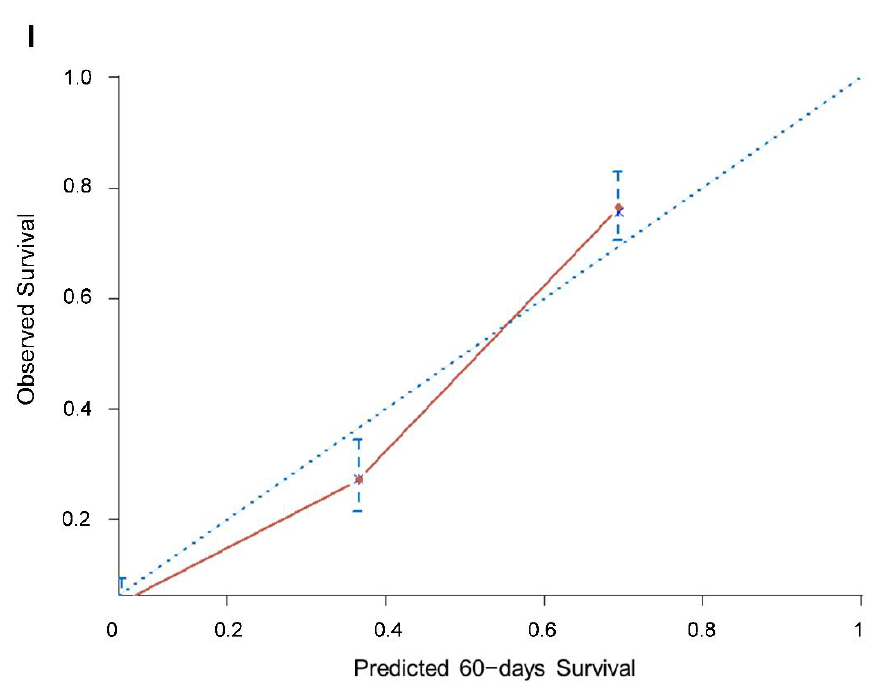
Figure 2. Calibration plots of the PaP score nomogram for 15-, 30- and 60-day survival prediction of the development cohort ( A – C ) and validation cohorts of 451 patients ( D – F ) and 549 patients ( G – I ). The X-axis represents the nomogram-predicted probability of survival; Y-axis represents the observed survival probability (Kaplan–Meier estimates). A perfectly accurate nomogram prediction model would result in a plot where the observed and predicted probabilities for given groups fall along the line. Dots with bars represent nomogram-predicted probabilities and 95% confidence in- tervals.